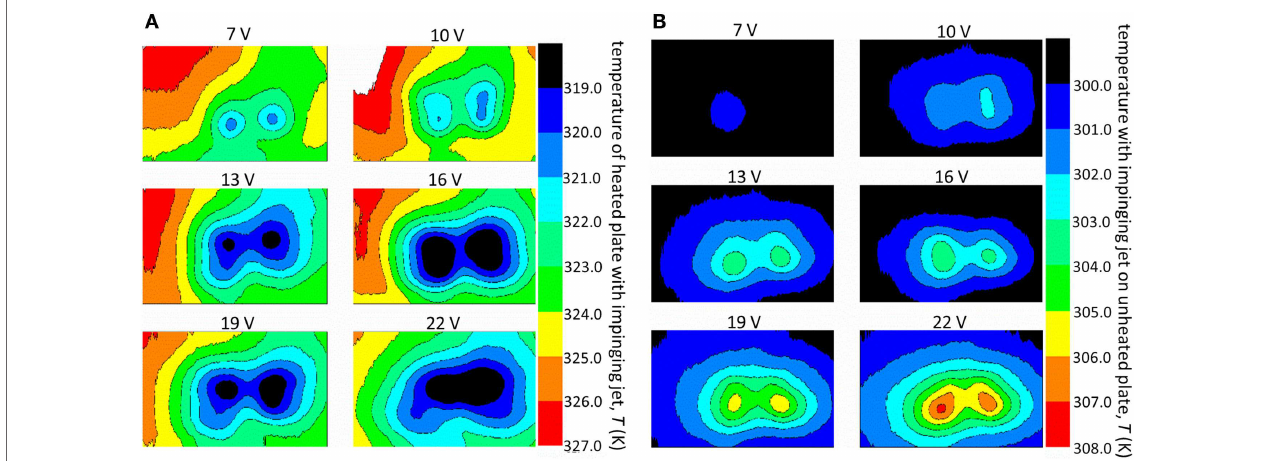
FIGURE 7 | The temperature distribution at different input voltages on the (A) heated plate and (B) unheated plate with the impinging jet generated from a rectangular PT for a gap of G = 1cm .